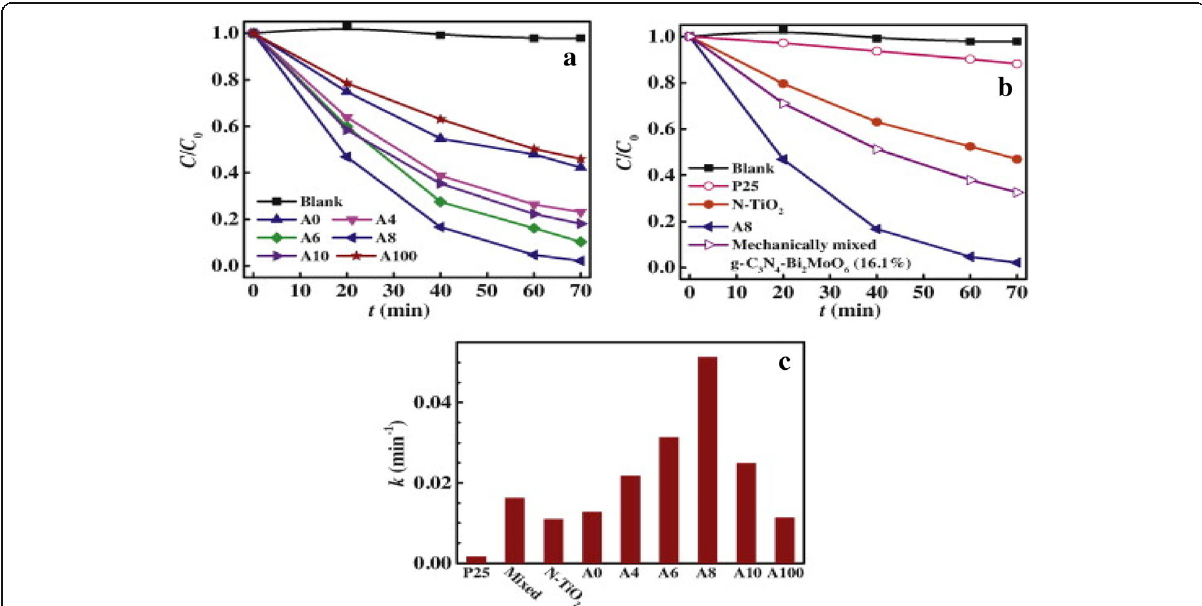
Fig. 8 a , b RhB degradation over various photocatalysts and c corresponding rate constants (k). Reproduced with permission [23]. Copyright 2014 Elservier